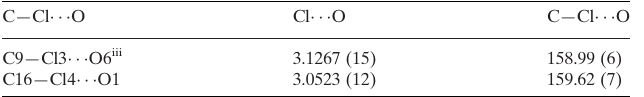
Halogen-bond geometry (A˚ , (cid:3)